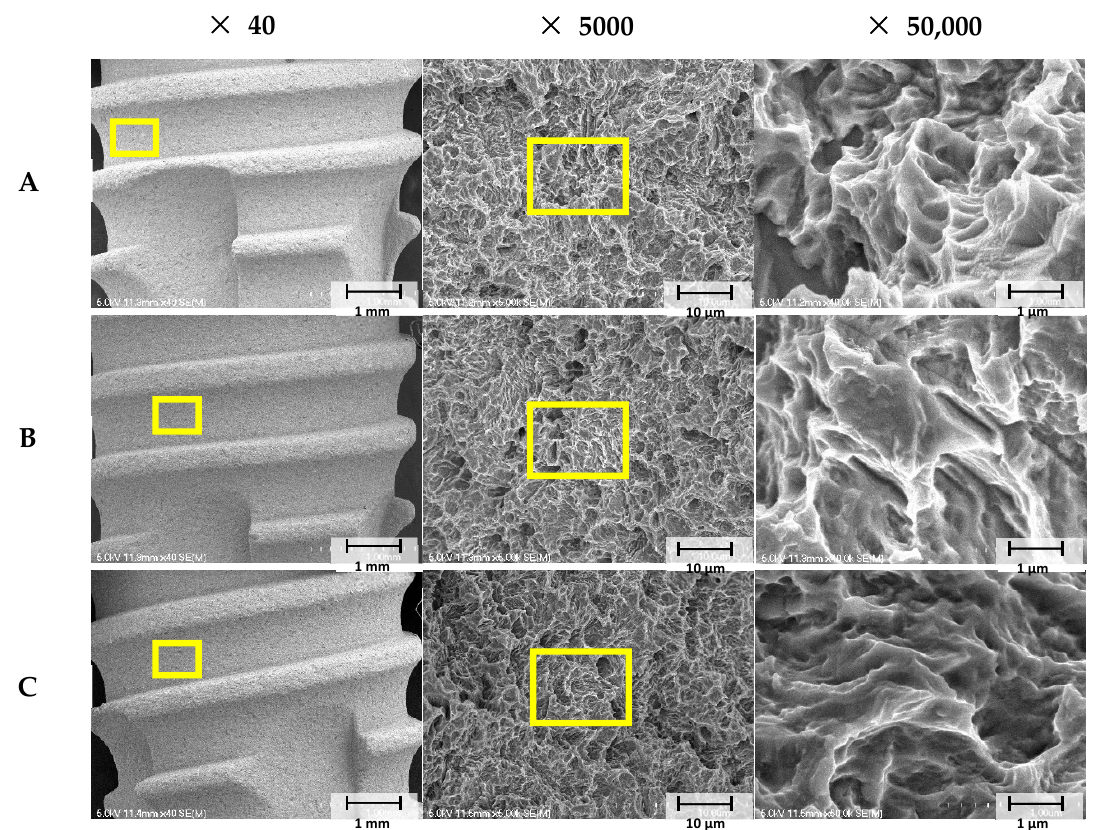
Figure 4. The scanning electron microscopy (SEM) images. ( A ) The SLA (Sandblasted, large grit, acid-etched implant surface) group, ( B ) The GA (glutaraldehyde) group, and ( C ) the GR (gamma-radiation) group. [Original magnifications: ×40, ×5000, and ×50,000].